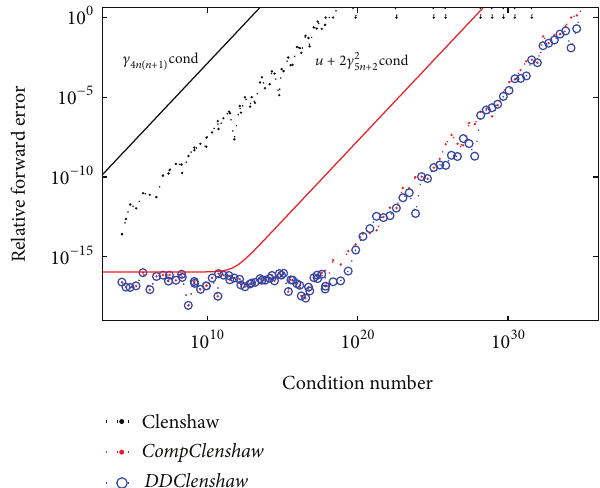
Figure 3: Accuracy of evaluation of polynomial converted from 𝑝(𝑥) = (𝑥−0.75) 7 (𝑥−1) 11 by the 𝐷𝐷𝐶𝑜𝑛 V 𝑒𝑟𝑡 algorithm in Legendre basis with respect to the condition